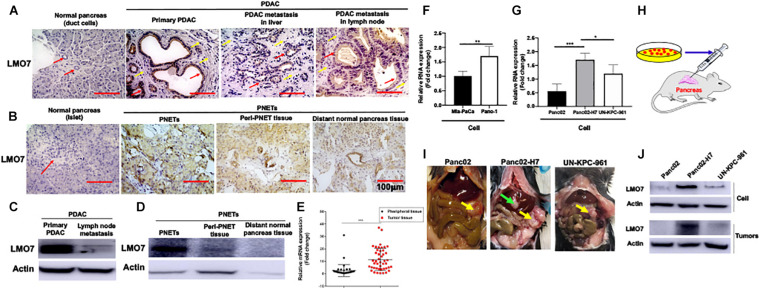
Increased expression of LMO7 protein and mRNA in human and mouse PC tumors. (A) Detection of LMO7 expression in human primary and metastatic PC tumors. Immunohistochemical staining was used to detect LMO7 in human normal pancreas, primary PDAC, and metastatic PDAC in liver and lymph node. Red arrows point to ductal cells in normal pancreas and PDAC tumors. Weak staining of LMO7 in normal pancreas and strong staining in PDAC tumors were shown. Yellow arrows point to remarkable desmoplasia in primary and metastatic PDAC tumors. (B) Detection of LMO7 expression in human PNETs. Immunohistochemical staining was used to detect LMO7 in normal human pancreas, PNETs, peri-PNET tissue, and distant normal pancreas tissue. Red arrow points to islet in normal pancreas without positive staining of LMO7. On the contrary, a strong staining of LMO7 was detected in primary PNETs; a modest staining of LMO7 in peri-PNET tissue and distant normal pancreas tissue. PNET displayed a typical nested organoid pattern. (C) Western blot detected the expression of LMO7 in primary and metastatic human PDAC tumors. (D) Western blot detected the expression of LMO7 in PNETs and peri-PNET tissue. (E) LMO7 mRNA expression in 45 human PDAC tumors and peritumoral tissues. The paired PDAC tumors and adjacent tissues were harvested from 45 human patients. The significant increase in LMO7 mRNA expression was detected in the tumors compared to peritumoral tissues by qPCR. (F) qPCR detected LMO7 mRNA expression with the level that is higher in human Panc-1 cells than that in Mia-PaCa-2 cells. (G) qPCR detected the LMO7 expression with the level that is higher in mouse Panc02-H7 cells than that in Panc02 cells and UN-KPC-961 cells. (H) Schematic diagram of the establishment of orthotopic murine PC models in wild-type C57BL/6 mice. (I) The representative images show orthotopic murine PC models with or without liver metastasis induced with Panc02, Panc02-H7, or UN-KPC-961 cells. Yellow arrow points to orthotopic PC tumors without liver metastasis. Green arrow points to metastatic tumors in liver. (J) Western blot detects the strong expression of LMO7 protein in Panc02-H7 cells and its derived tumors in comparison to LMO7 expression in Panc02 and UN-KPC-961 cells as well as the derived tumors. *p < 0.05; **p < 0.01; ***p < 0.001.